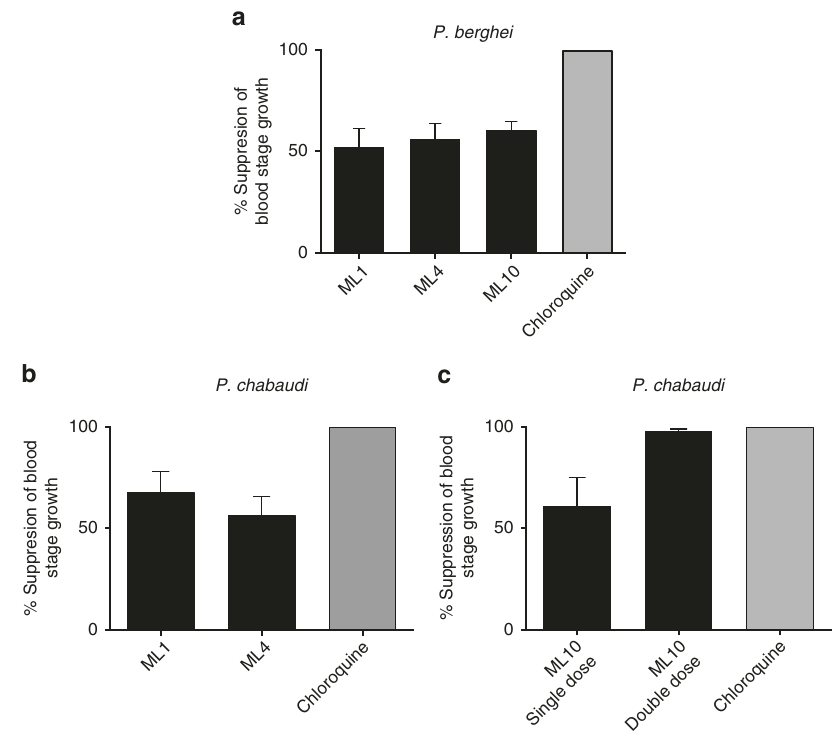
Fig. 1 In vivo ef fi cacy of PKG inhibitors against rodent malaria parasites. a Groups of fi ve female BALB/c mice were infected with 1x10 7 /ml P. berghei (ANKA) blood stage parasites in a Peters 4-day test and were given a twice daily dose (25 mg/kg) of one of three test compounds by oral gavage. Chloroquine was used as a positive control at a single daily oral dose of 10 mg/kg. b Groups of fi ve female BALB/c mice were infected with 1×10 7 P. chabaudi (AS) blood stage parasites and were given a single oral dose (50 mg/kg) of either ML1 or ML4 by oral gavage just prior to the predicted onset of schizogony. Chloroquine was used as a positive control at a single daily oral dose of 10 mg/kg. c Groups of fi ve BALB/c mice were infected with 1×10 7 P. chabaudi (AS) blood stage parasites and were given either a single or twice daily oral dose (50 mg/kg) of ML10 by oral gavage. The fi rst dose was given to both groups of mice just prior to the predicted onset of schizogony and in one group this was followed 3 h later when schizogony was predicted to have been completed. The data are from single experiments each performed on a group of fi ve mice. Error bars show the